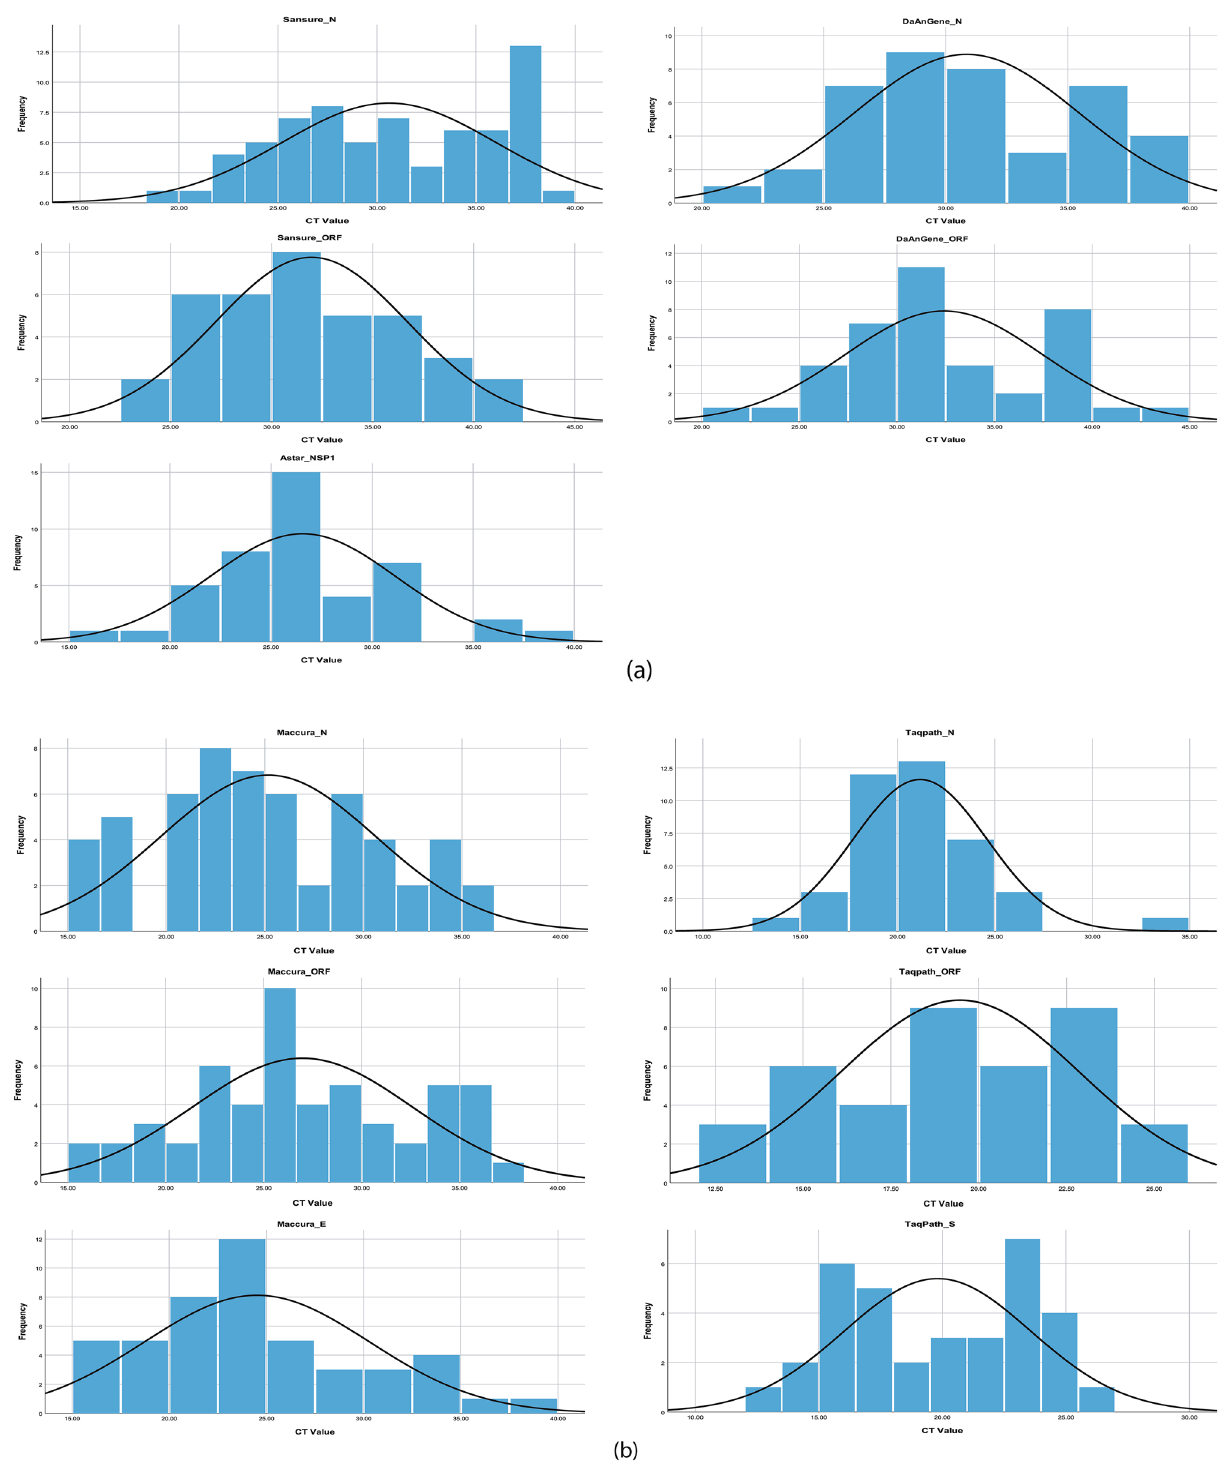
Figure 4. Frequency of Ct value reported by the Kits for their target genes with normal curves. ( a ) Frequency of Ct value for target genes of Sansure, Da An Gene and A*Star; ( b ) Frequency of Ct value for target genes of Maccura and